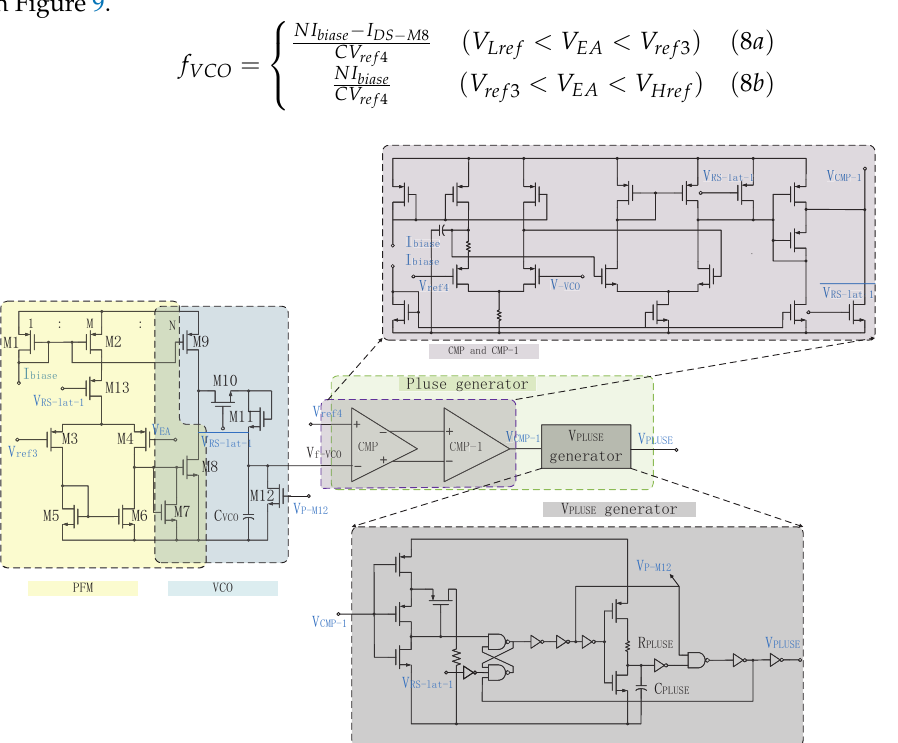
Figure 8. The structure of the oscillation unit composed of PFM amplifier, VCO, and Pluse generator.